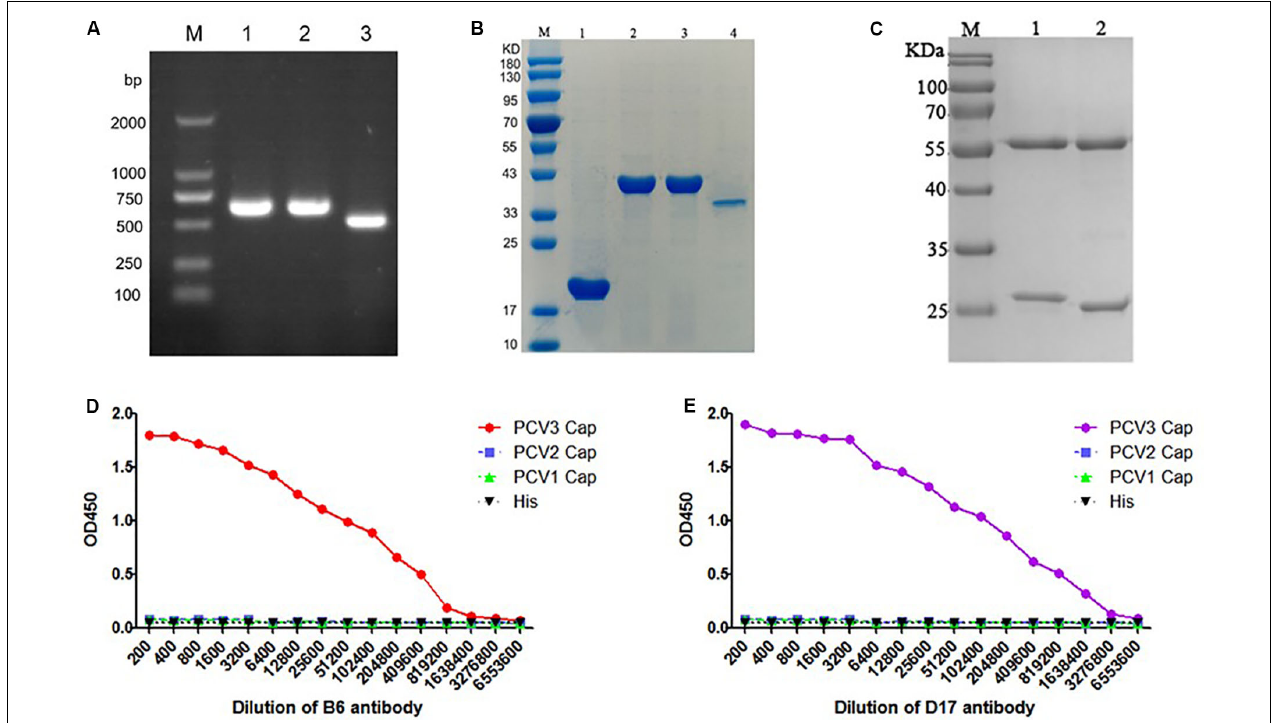
FIGURE 3 | (A) PCR nucleic acid electrophoresis of E. coli BL21 (DE3) consisting of the pET-32a-PCV Cap plasmid, and the destination fragments were amplified by PCR. M, DL2000 DNA Marker; Lane 1, PCR nucleic acid electrophoresis of pET-32a-PCV1 Cap in E. coli BL21 (DE3); Lane 2, E. coli BL21/pET-32a-PCV2 Cap; Lane 3, E. coli BL21/pET-32a-PCV3 Cap. (B) Purification of the PCV3 Cap protein and SDS-PAGE electrophoretic results of purified PCV Cap protein and the size of the bands were 40, 40 and 35 kDa, respectively. M, Protein Marker; Lane 1, BL21 (DE3)/pET32a purified protein sample; Lane 2, BL21 (DE3)/pET32a-PCV1 Cap purified protein sample; Lane 3, BL21 (DE3)/pET32a-PCV2 Cap purified protein sample; Lane 4, BL21 (DE3)/pET32a-PCV3 Cap purified protein sample. (C) The SDS-PAGE results of purification monoclonal antibody. M, Protein Marker; Lane 1, B6 mAb; Lane 2, D17 mAb. (D) The potency analysis titer curve of purified B6 mAb. (E) The potency analysis titer curve of purified D17